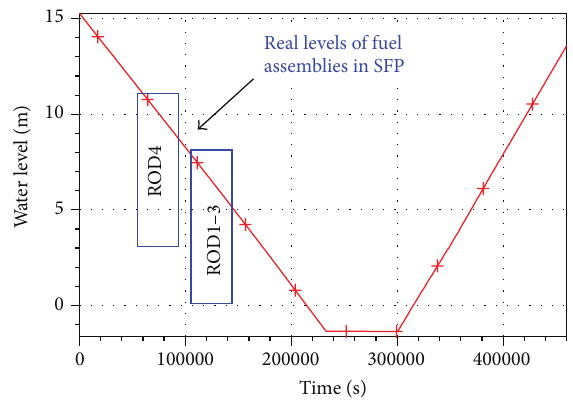
Figure 5: Water level in spent fuel pools.